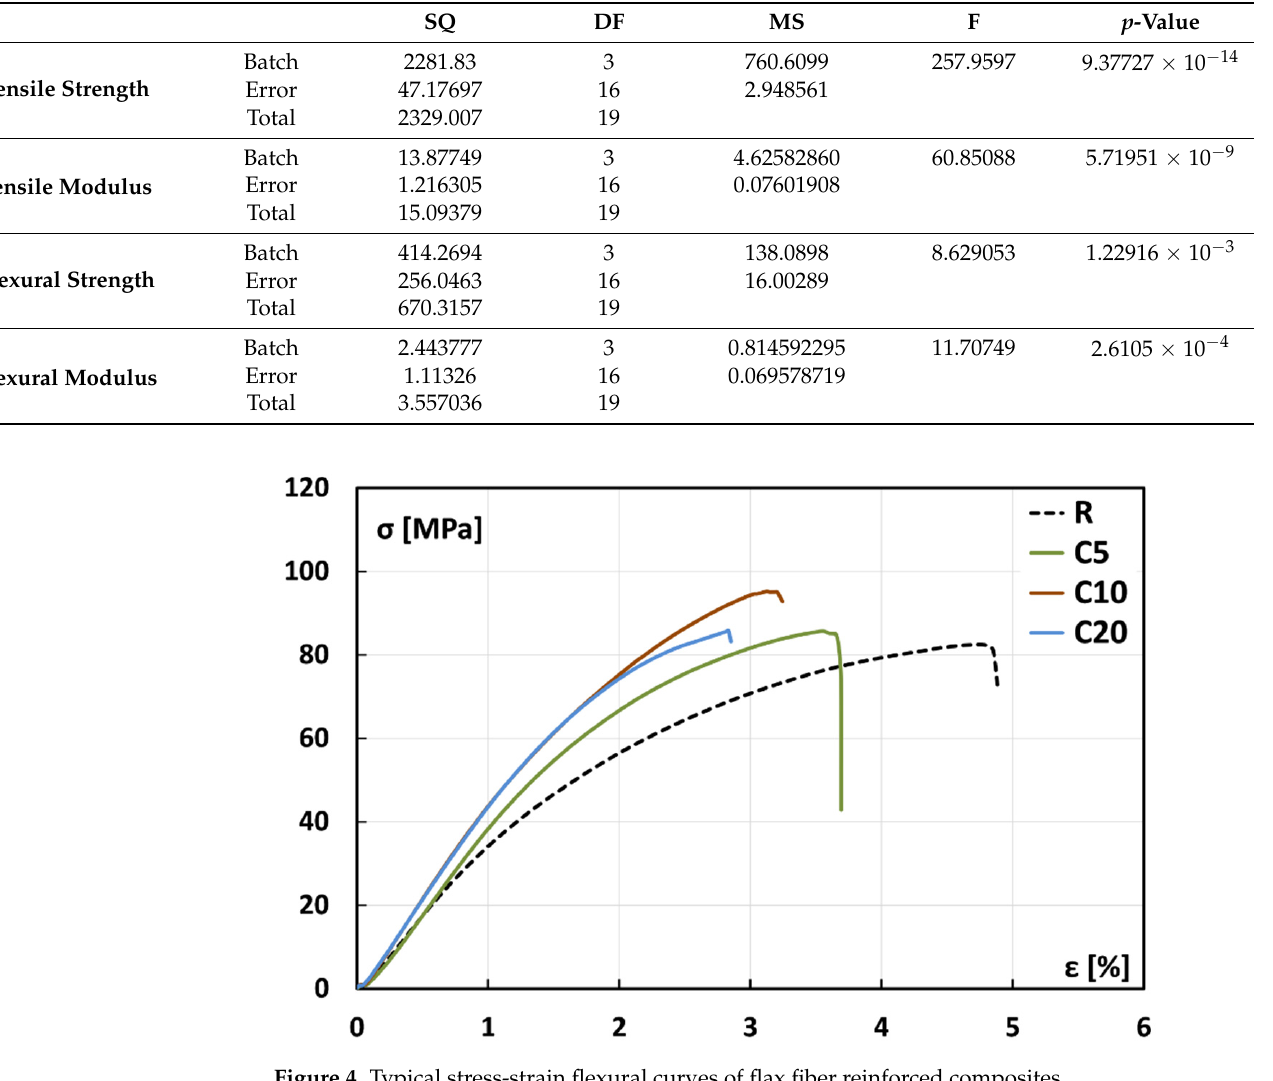
Figure 4. Typical stress-strain flexural curves of flax fiber reinforced composites. All these results evidence that the compatibility between epoxy matrix and flax fibers is noticeably improved after the sodium citrate treatment, for weight concentrations of the treating solution up to 10%. In particular, the increase in both tensile and flexural stiffness shown by C5 and C10 composites in comparison to the untreated one (i.e., R composites) can be explained taking into account that a stronger fiber–matrix adhesion results in more restrictive constraints on the relative displacements between fiber and matrix, particularly in the linear elastic phase [21]. This beneficial effect of the proposed treatment on the fiber–matrix adhesion also leads to an evident strengthening of the C5 and C10 composites, as shown by their tensile and flexural strength values, noticeably higher than that of untreated samples. A wide literature can be found concerning the increase in the tensile and flexural quasi-static strength of NFRCs materials due to the improved fiber–matrix compatibility after chemical treatment [9,29,30] of natural fibers. Furthermore, the quasi-static mechanical results point out that the effectiveness of the proposed treatment is more evident on the tensile properties of the resulting composites in comparison to their flexural properties (see Figures 1 and 2). As stated by other authors [9], this can be explained considering that the flexural failure mode shows less fiber pull-out phenomena, due to the applied stress direction, perpendicular to the composite sample in the three-point bending